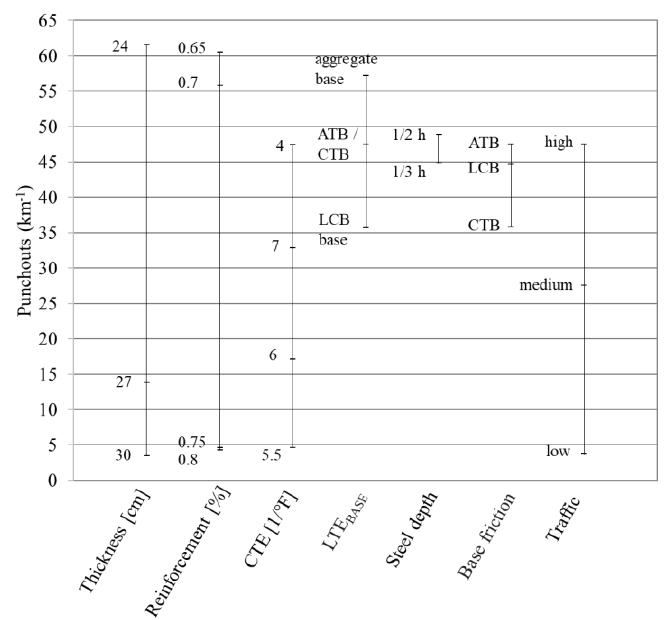
Figure 8. Relative impact of the individual variables on the punchouts prediction by the MEPDG. Figure 9 indicates the influence of different reinforcement ratios and slab thicknesses